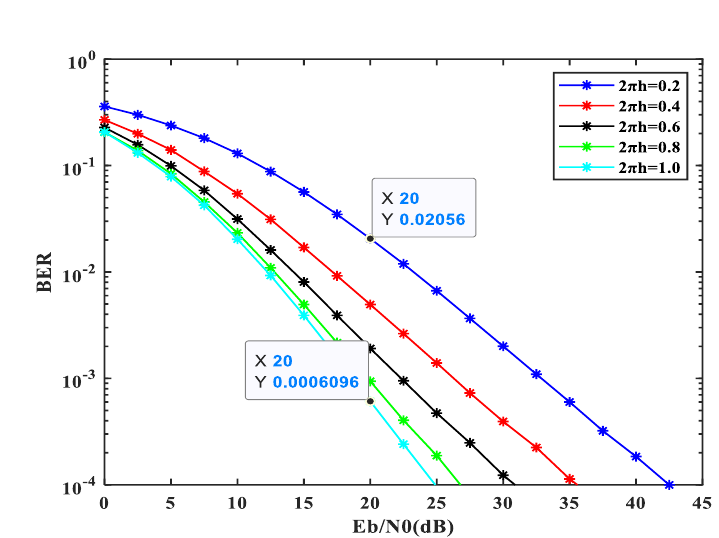
Figure 11. BER versus SNR of PM-OFDM-CDMA (Rayleigh channel).